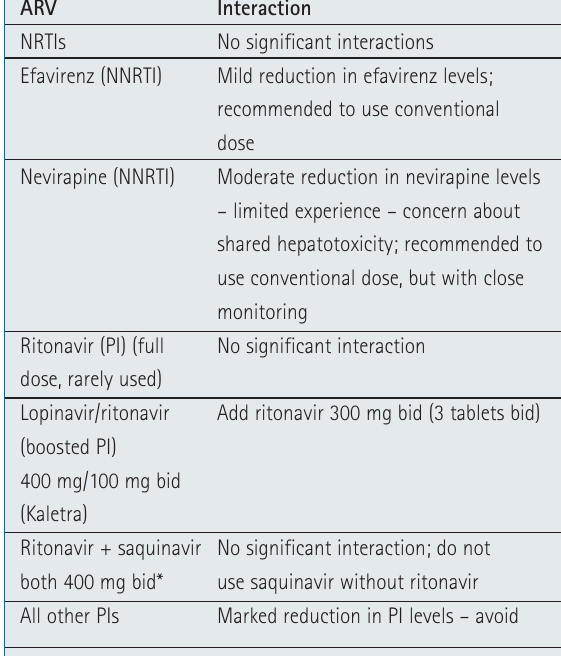
TABLE VII. ART INTERACTIONS WITH RIFAMPICIN